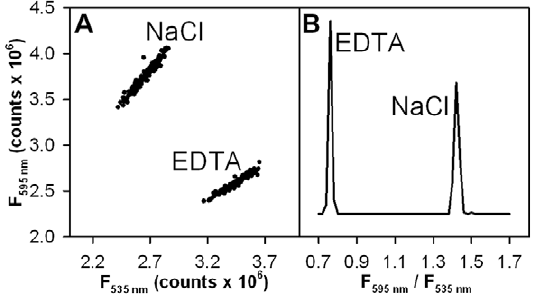
Figure 3. PA-CMG2 high throughput screening assay perfor- mance. A polystyrene 384 well-plate filled with 7.5 nM PA E733C*AF488 and 13 nM CMG2 R40C*AF546 in HBST plus either 5 mM NaCl (negative control; 168 wells) or 5 mM EDTA (positive control; inhibitor; 168 wells). A ) Scatter plot of donor ( l em =535 nm) and acceptor ( l em =595 nm) emission showing the shift induced by addition of EDTA (positive inhibitor control). B ) Histogram of the F 595 nm /F 535 nm ratio taken from the same data. For these data